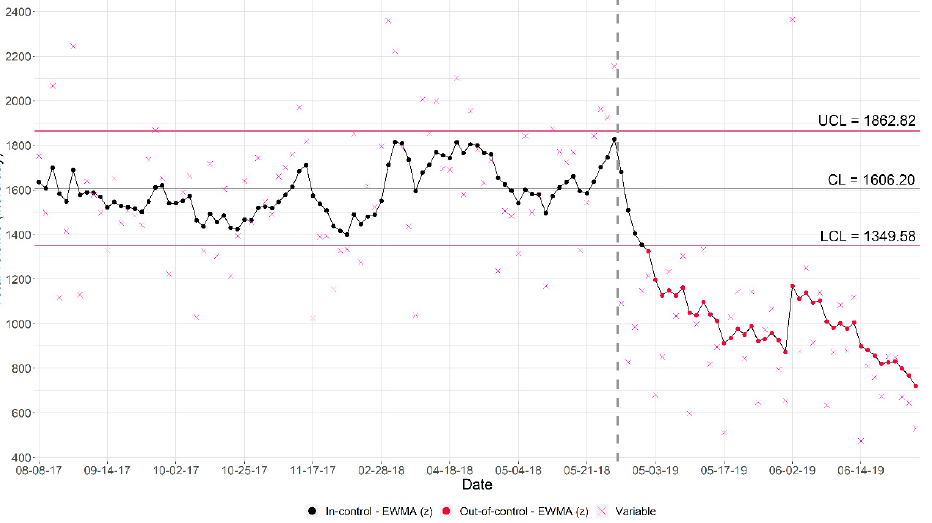
Figure 2. EWMA Control Chart—Total volume per day.